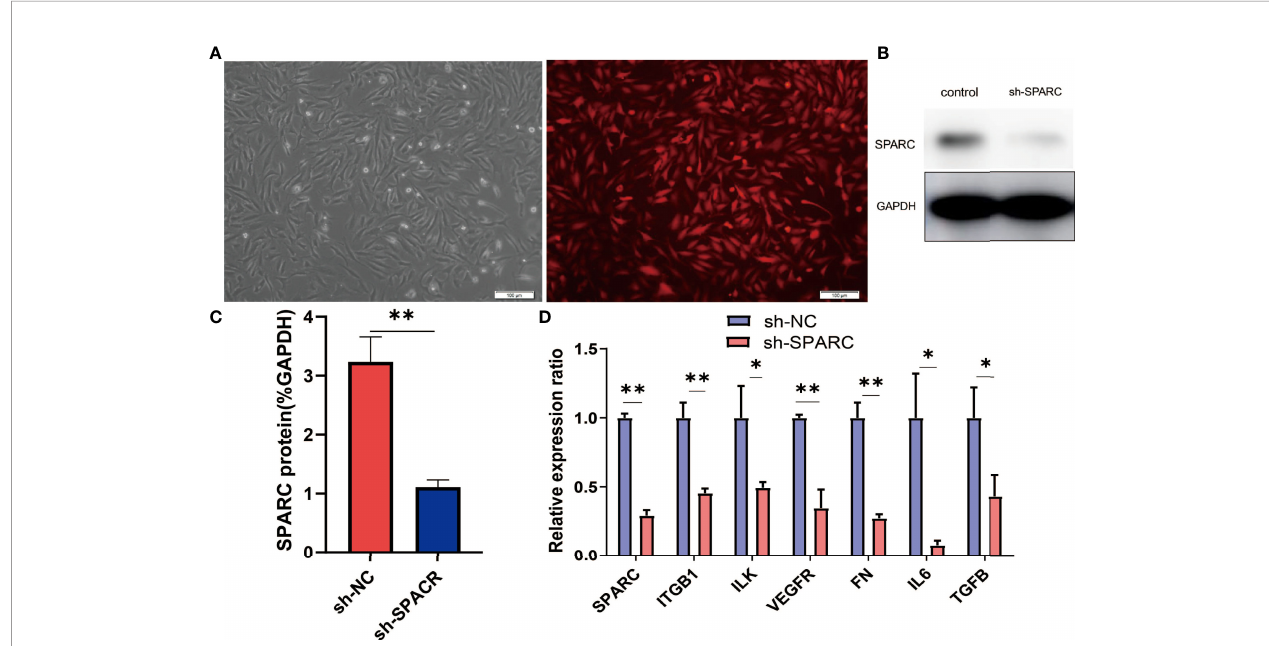
FIGURE 5 | The related gene expression in SPARC gene silencing experiments. (A) Representative fl uorescence fi gure. (B , C) Protein level of SPARC in SPARC gene silencing experiments. (D) The mRNA level in SPARC gene silencing experiments. *: p < 0.05,**: p <